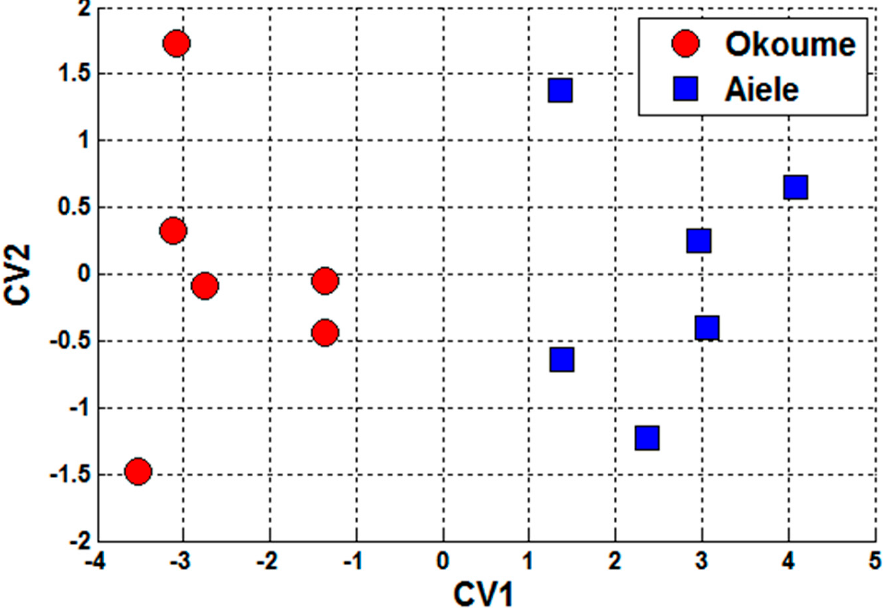
Figure 9. Discriminant function analysis (DFA) plot performed on essential oils, namely, okoume and aiele, using the conductance change (Delta-G) of sensors as a response feature.